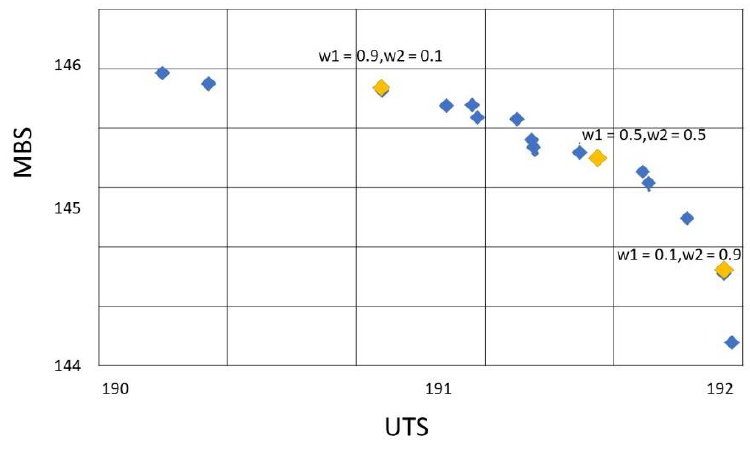
Figure 4. Pareto front of GA.